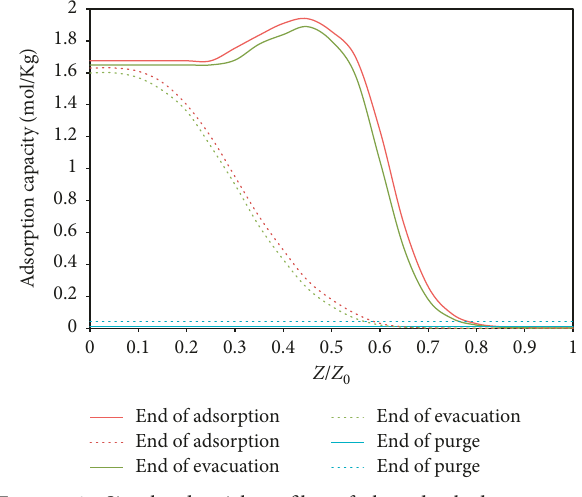
Figure 9: Simulated axial profiles of the adsorbed amount of dichloromethane and acetone at the end of different steps of the cycle at steady state. Solid lines: dichloromethane and dotted lines: acetone.